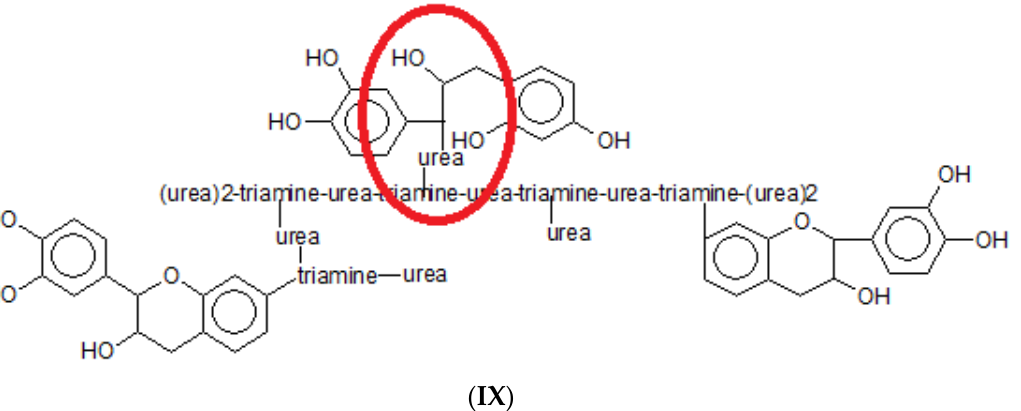
Figure 11. A rare example of a detected structure in which the amide group of a urea has reacted and linked to a flavoid unit of the tannin.